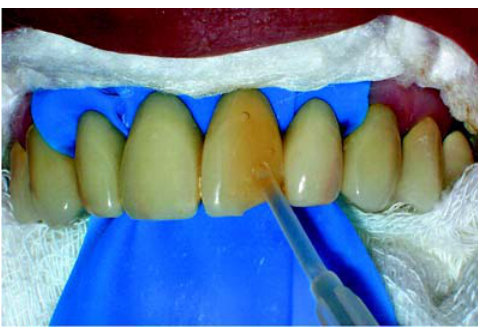
FIGURE 3- Ceramic etching with 10% hydrofluoric acid